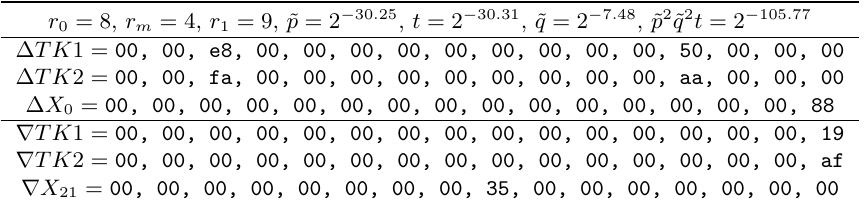
Table 13: The 21-round boomerang distinguisher for ForkSkinny-128-256